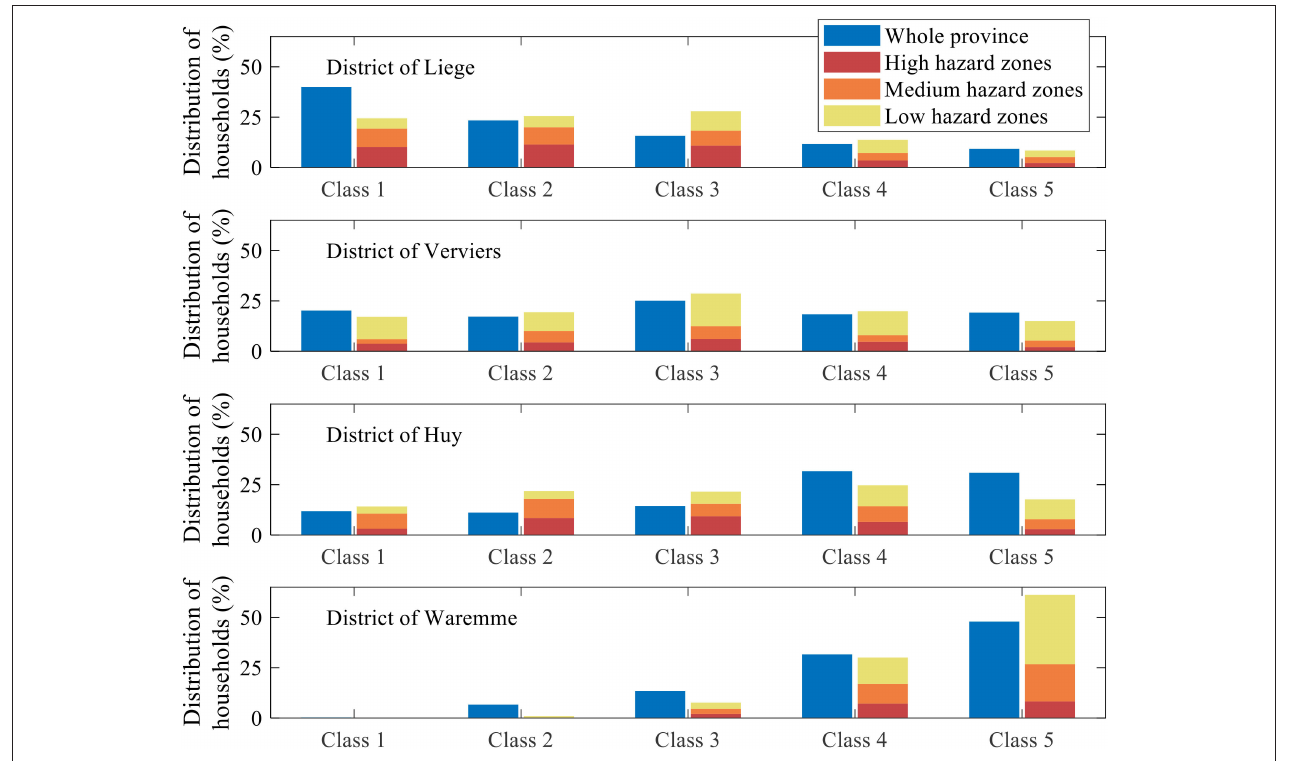
FIGURE 8 | Distribution of households in the four districts of the Province regarding their ISD class and their location in flood hazard